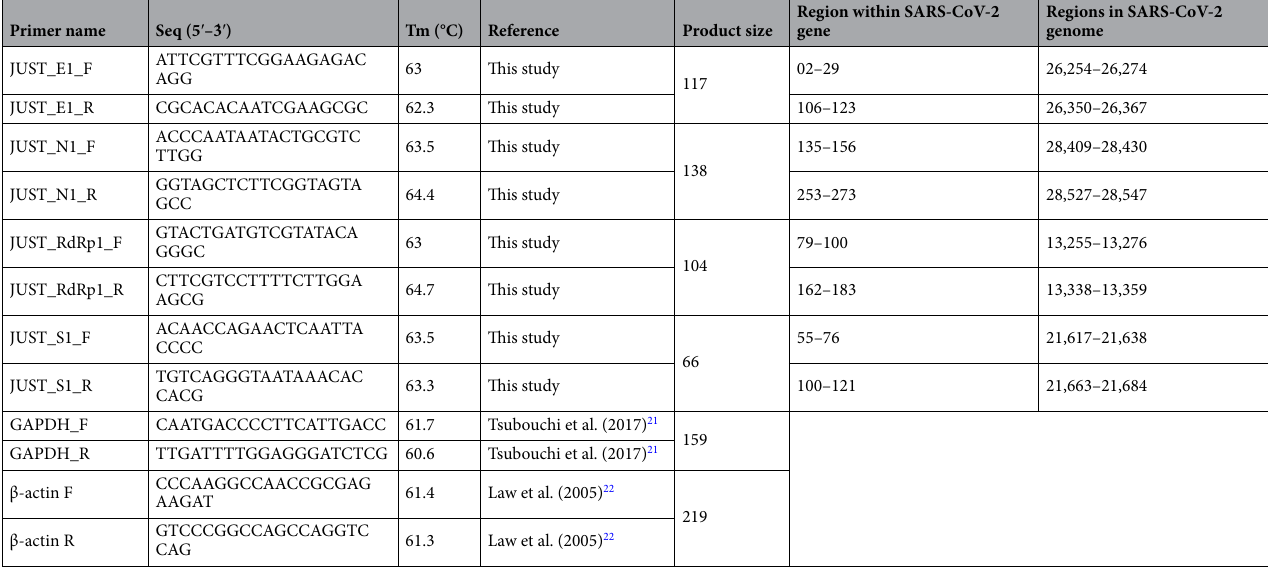
Table 1. List of the primers used in this study.